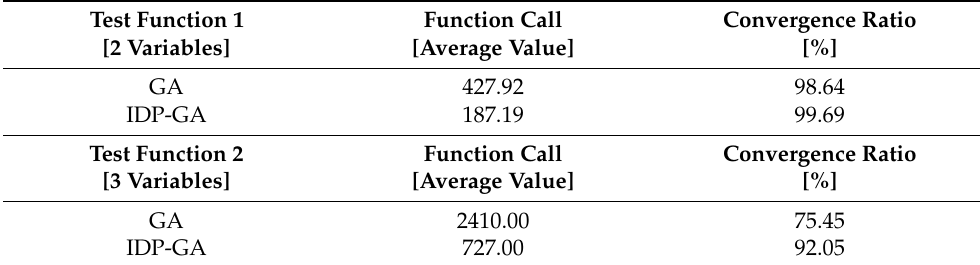
Table 1. Performance comparison of conventional GA and IDP-GA.